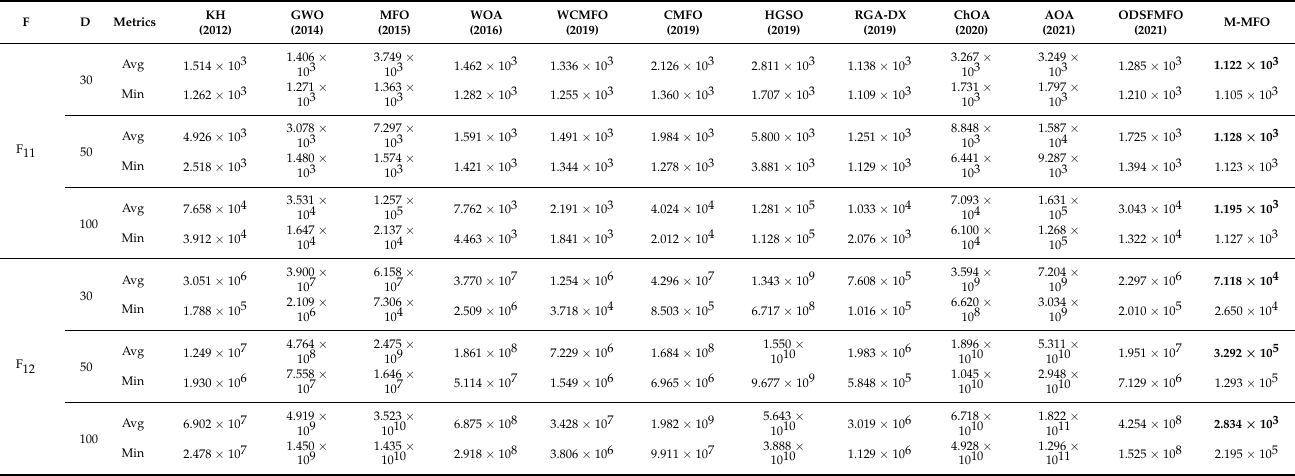
Table A3. Results of the comparative algorithms on hybrid test